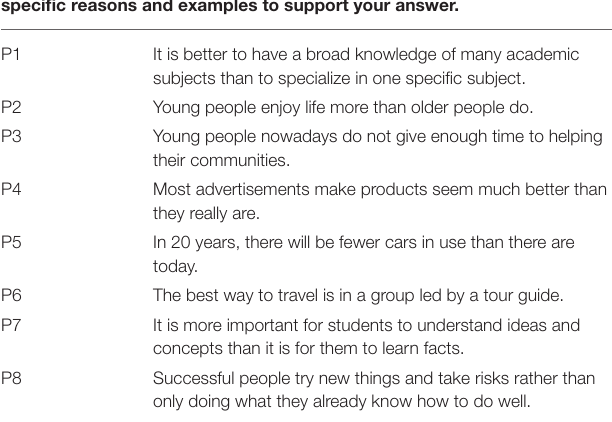
TABLE 2 | Summary of